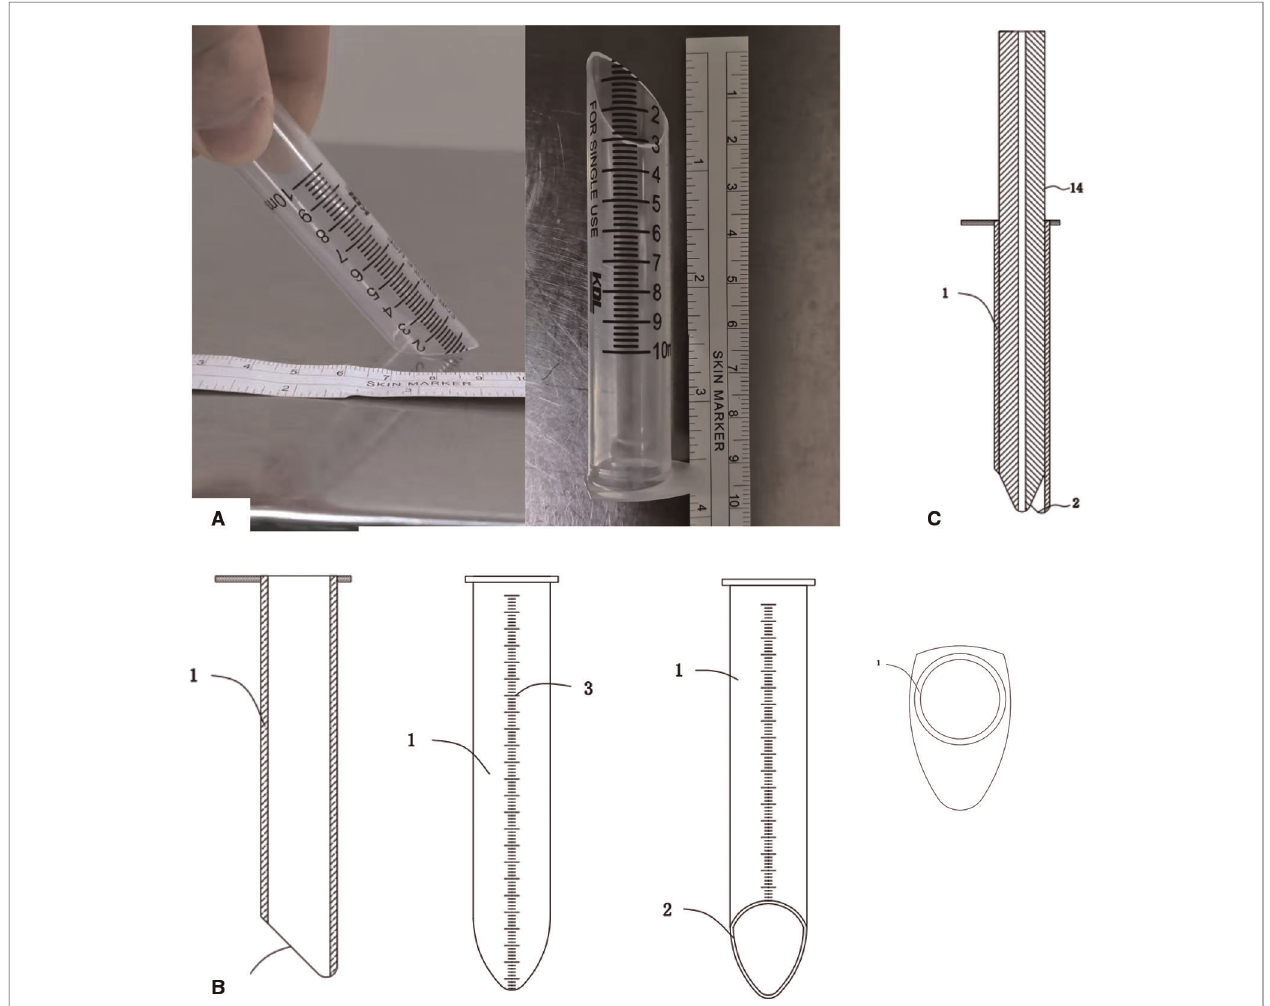
FIGURE 5 | Custom-made working tube. ( A ) Homemade working channel with 10 ml syringe. ( B ) Schematic diagram of the cross-section and each side view of the custom-made working channel. ( C ) Schematic diagram of the cross-sectional view of the pencil tip and custom-made working